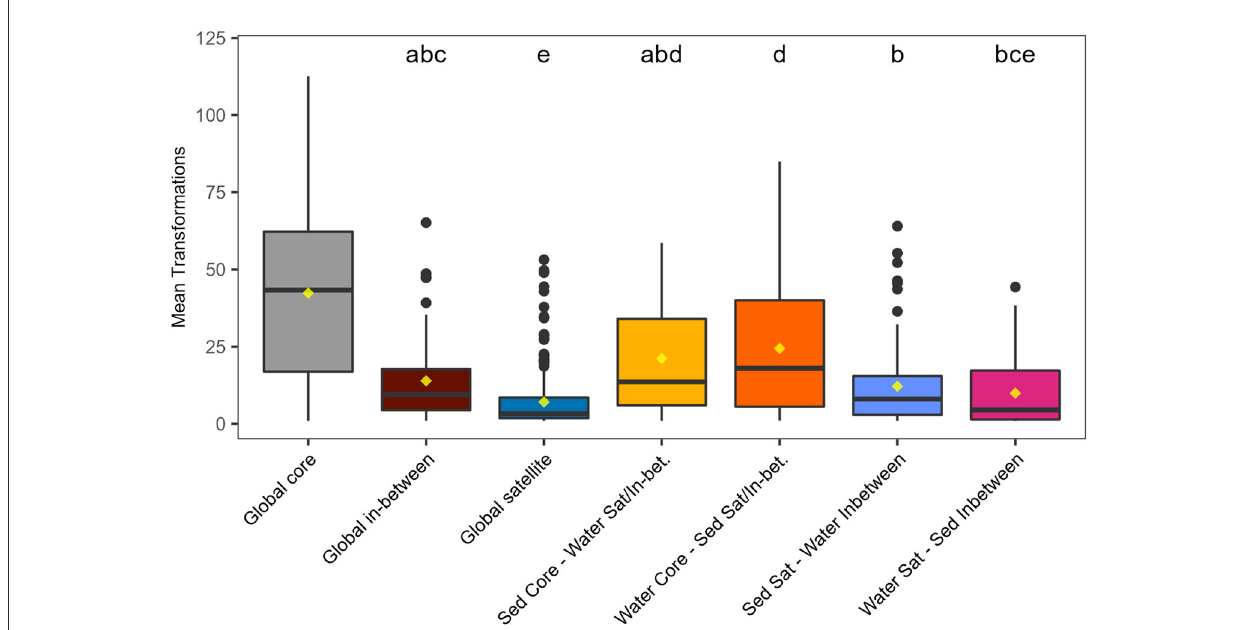
FIGURE5 Mean number of putative transformations per molecular formula (see Methods). Horizontal lines indicate medians, the yellow dots indicate the mean. Boxplots without matching letters were statistically different from each other (Kruskal-Wallis one-way analyses of variance followed by Dunn’s test). Upper and lower hinges correspond to the first and third quartiles, respectively. The whiskers extend to the largest and smallest value within 1.5 times the interquartile range. Data beyond whiskers are displayed as outlier